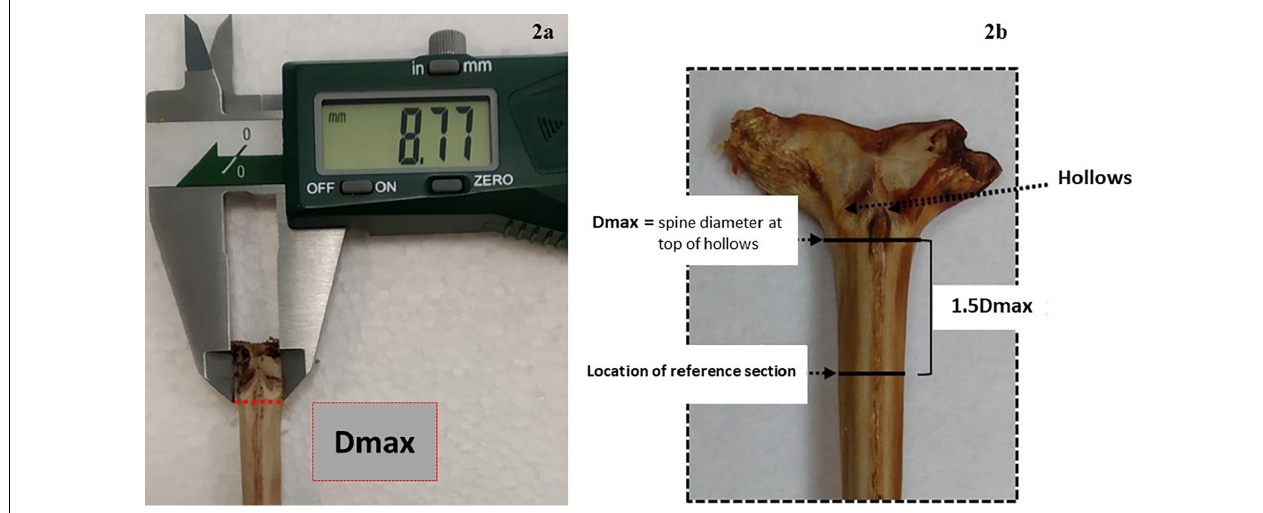
FIGURE 2 | Description of the sectioning axis location: (a) an anterior view of the condyle base and the location of Dmax, which is manually measured with the calliper along the imaginary line below the hollows, (b) an anterior view of the condyle base and the location of the 1.5 cutting axis at 1.5 Dmax from the same imaginary